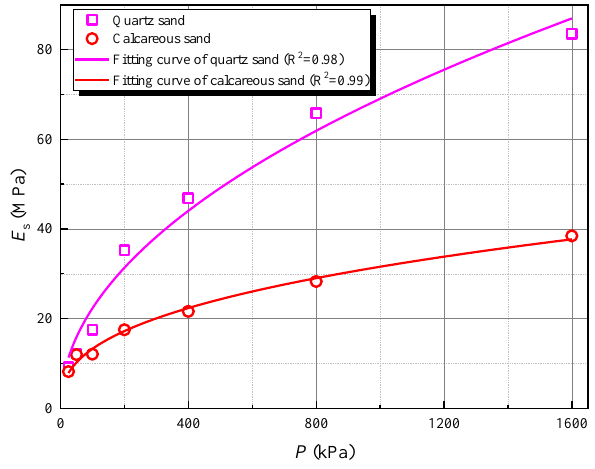
Figure 4. Correlation between compressive modulus and confining pressure.